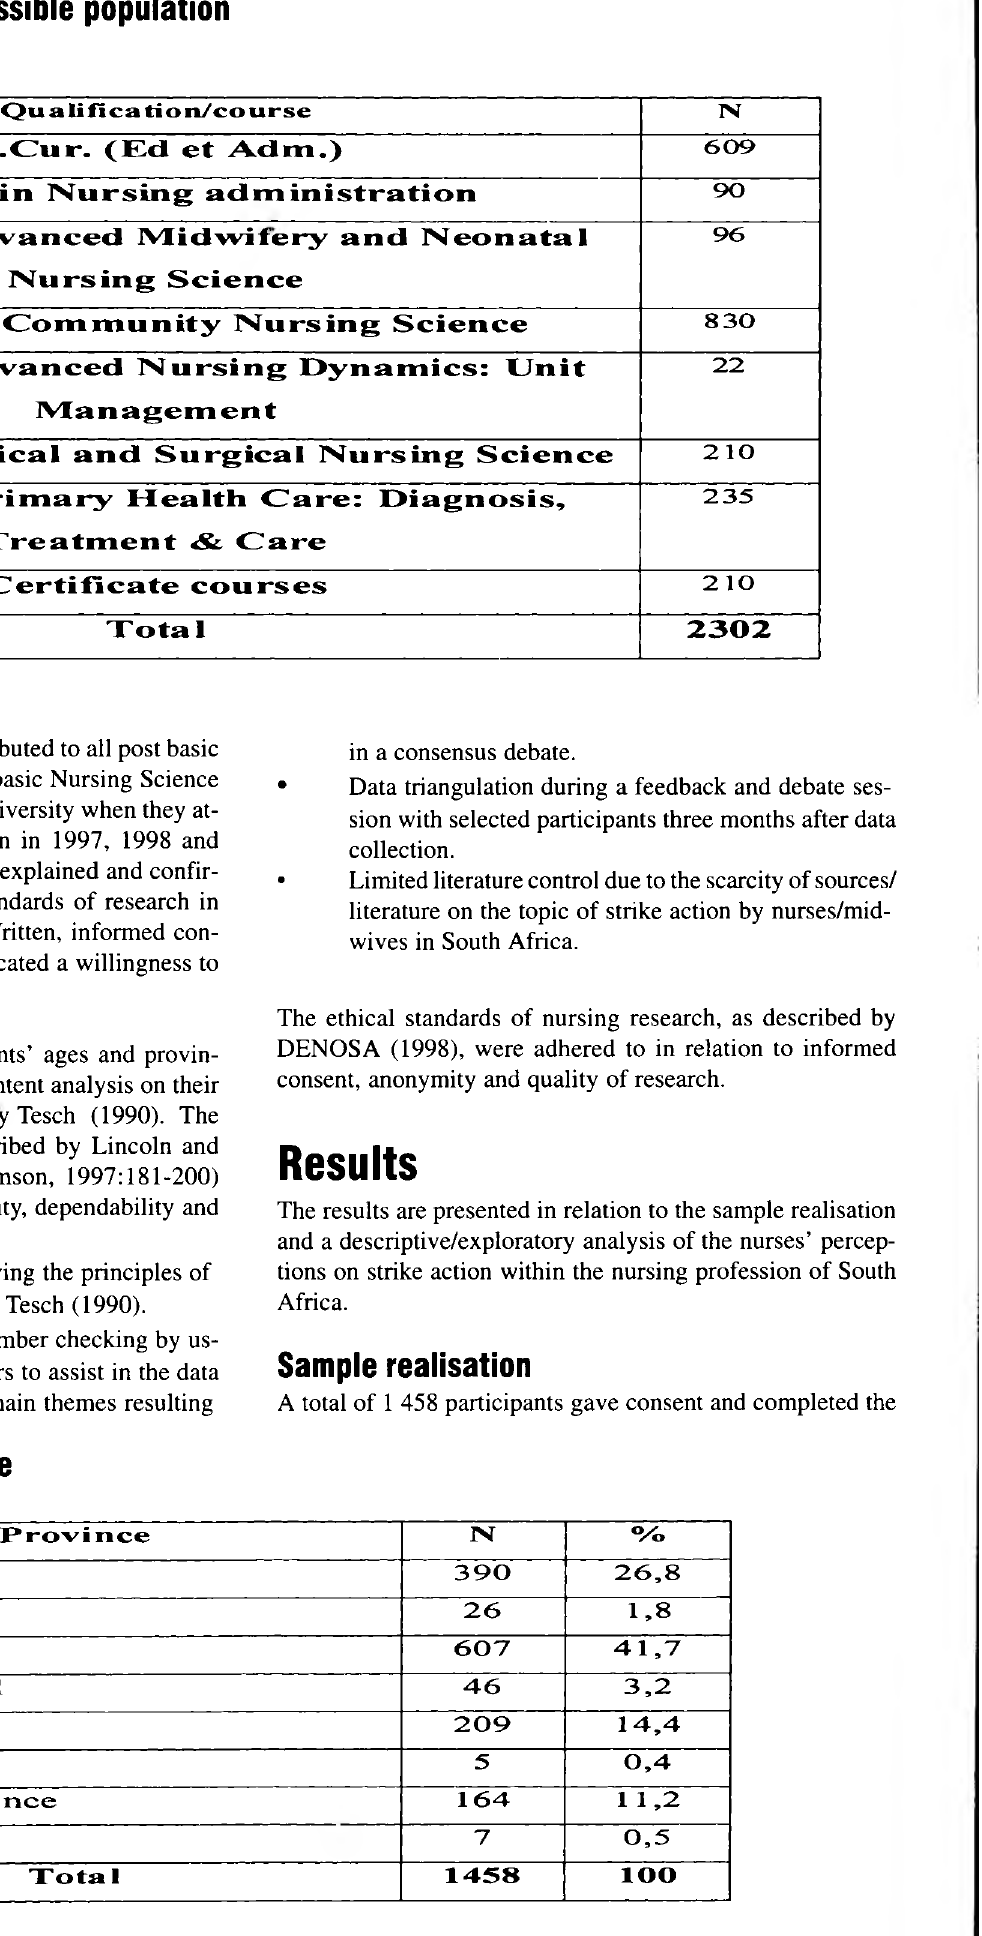
Table 1 : Distribution of accessible population